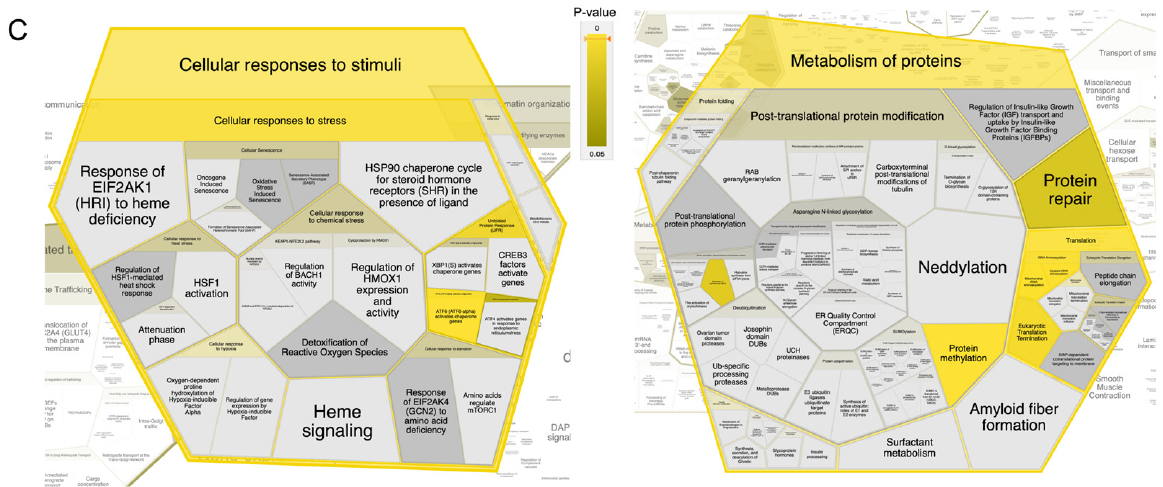
Figure 4. Integrated proteomics and metabolomics analysis, conducted with DIABLO, of the liver of gilthead seabream subjected to the net-handling challenge (NET). ( A ) Arrow plot of the separation between groups achieved with the first two components of the DIABLO model. Different shapes represent different data modalities. ( B ) Circos plots representing the Pearson correlation (correlation cutoff = 0.9) between the 10 most-discriminatory proteins and metabolites selected by the first component of the DIABLO model. ( C ) Voronoi plots obtained with a REACTOME analysis tool represent two of the most overrepresented high category terms (FDR < 0.05), among the upregulated features selected by DIABLO. The p -value scale indicated in the figure legend corresponds to the adjusted p -value.